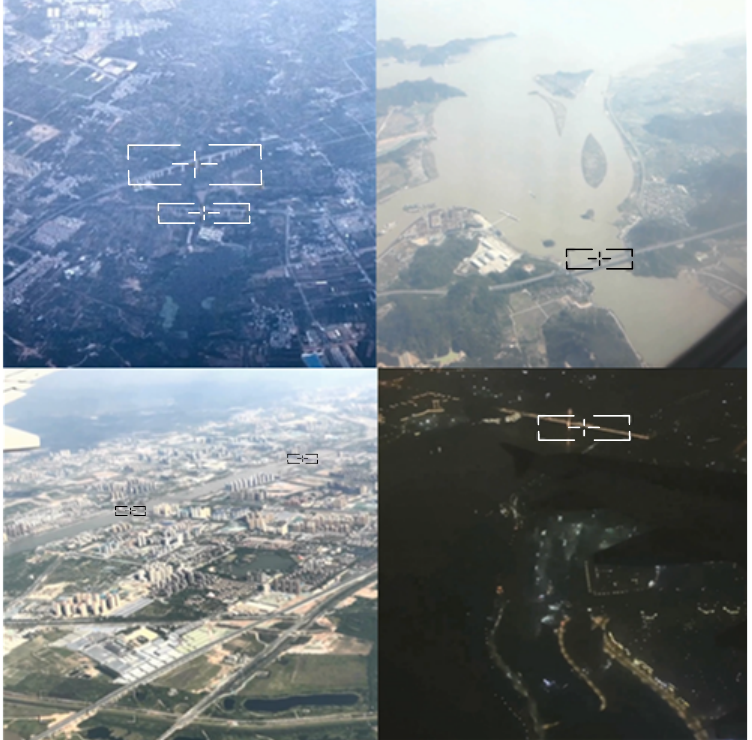
Figure 18. The actual output of the bridge detection in the aerial video using TinyYolo inference with the acceleration